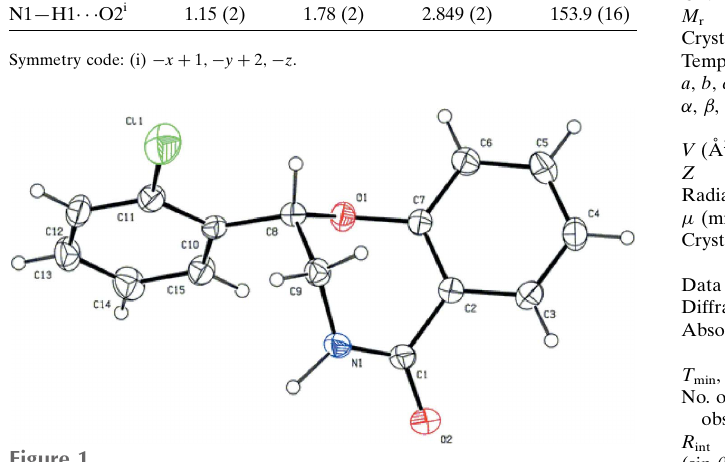
Table 2 Experimental details. Crystal data Chemical formula